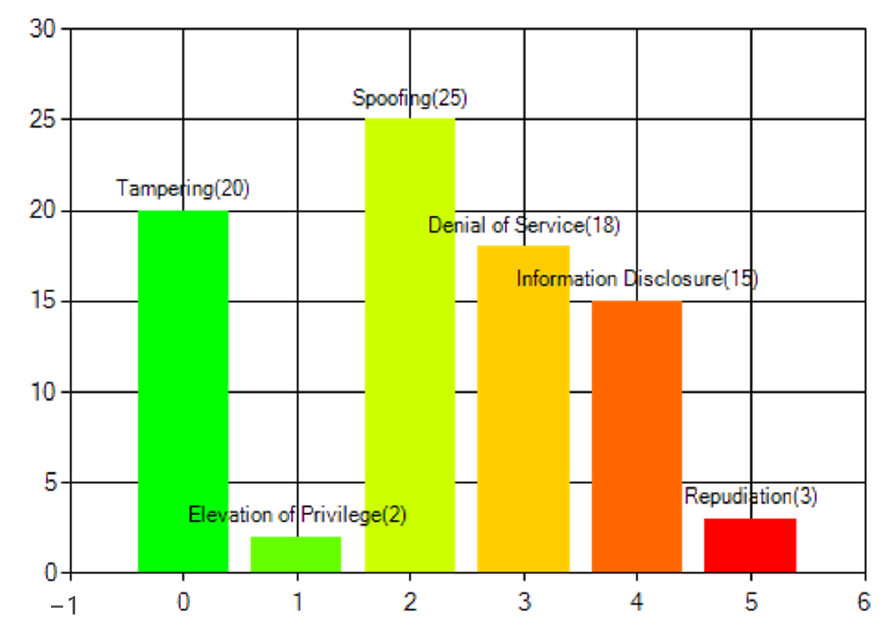
Figure 6. Classification of all identified threats according to the STRIDE